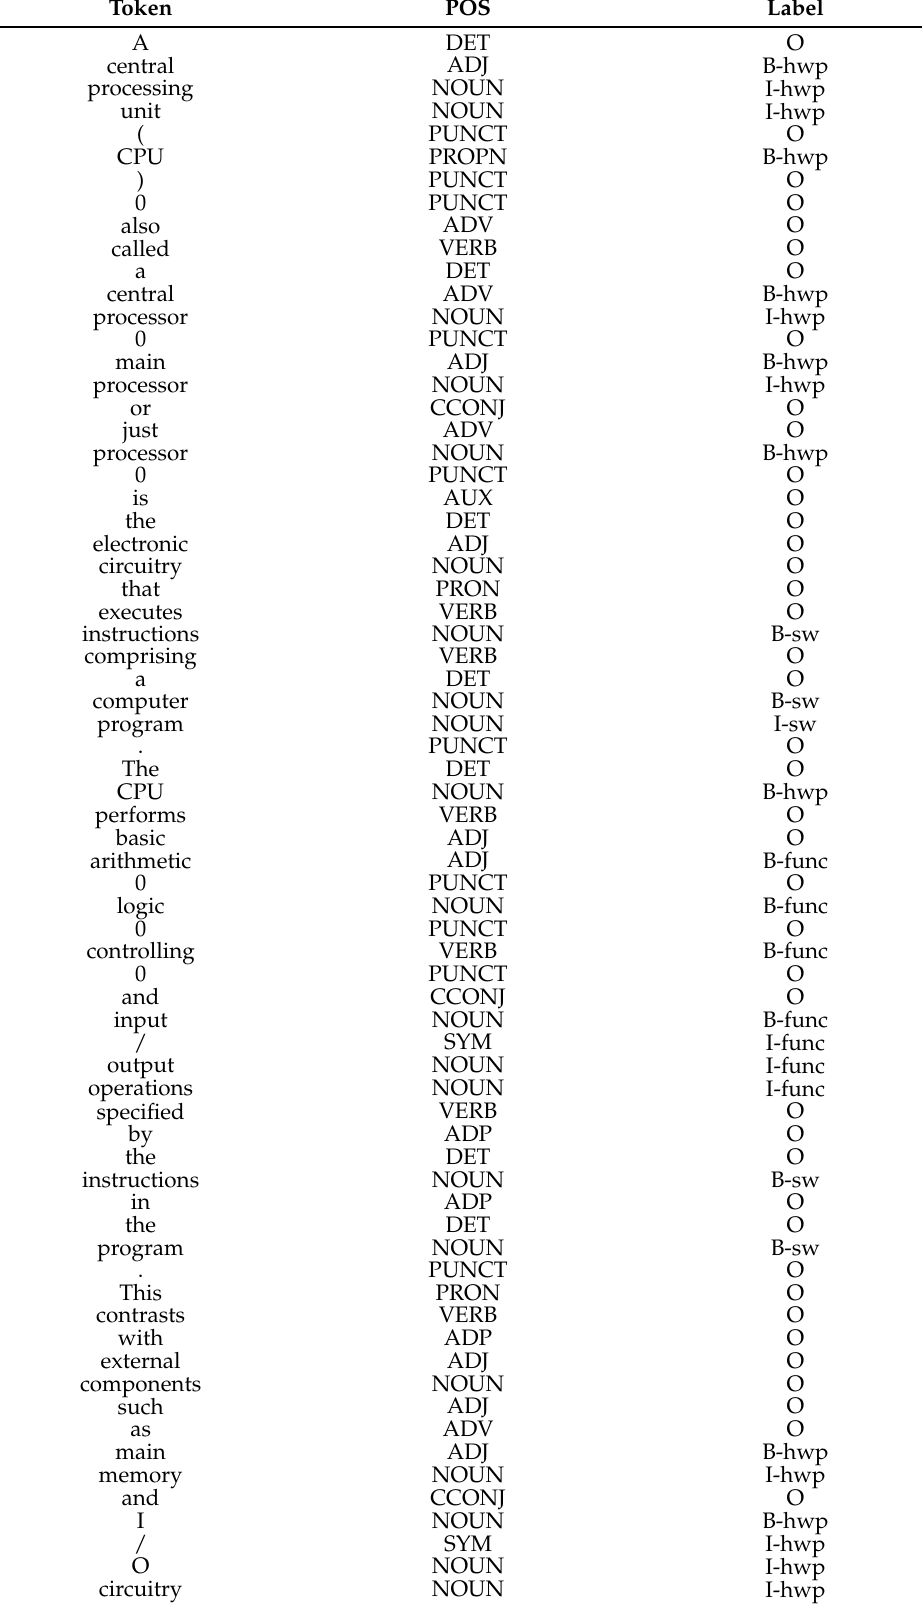
Table 9. Central processing unit article with POS